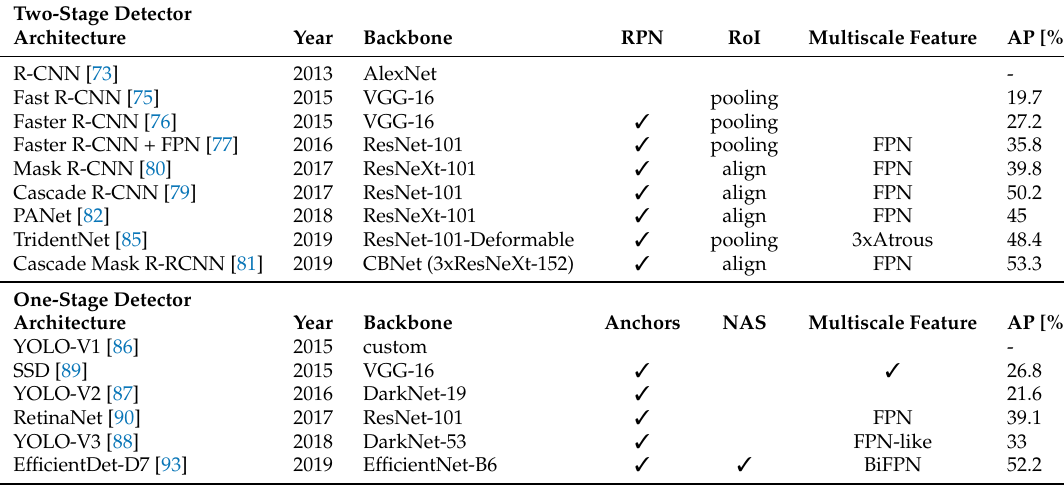
Table 4. Summary of the evolution of convolutional neural networks (CNNs) for object detection and the above-discussed cornerstones, divided into two- and one-stage detectors. The Backbone is the reported CNN used for feature extraction; RPN shows if a region proposal network is used; RoI describes which kind of pooling is used for the regions of interest; Anchors describes if prior anchor boxes are utilised; NAS describes if neural architecture search was used; Multiscale Feature describes the approach of multiscale feature extraction; and AP describes the performance on the MS-COCO